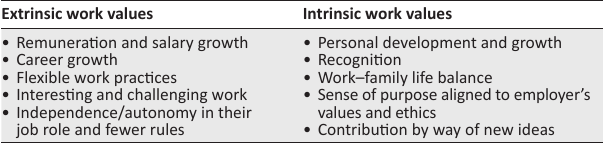
TABLE 1: Millennials’ extrinsic and intrinsic work